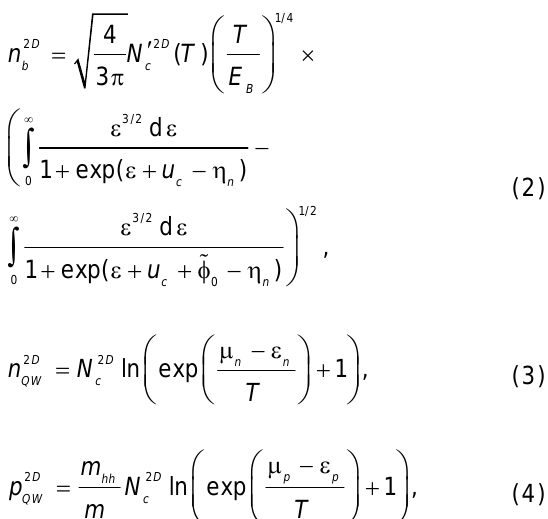
Fig. 1. Two schemes of electron transitions for CHCC-process and the studied AR in QW =  / T ,   = - e  / T ,  is electron potential,   n n are the quasi-Fermi levels for electrons and holes, and  are quantized energy levels of an electron  n p and a hole in the conduction and valence bands respectively, T is the temperature of electron–hole plasma in terms of energy. The quasi-Fermi levels for electrons and holes are measured from the band edges as well as quantized energy levels of local- ized